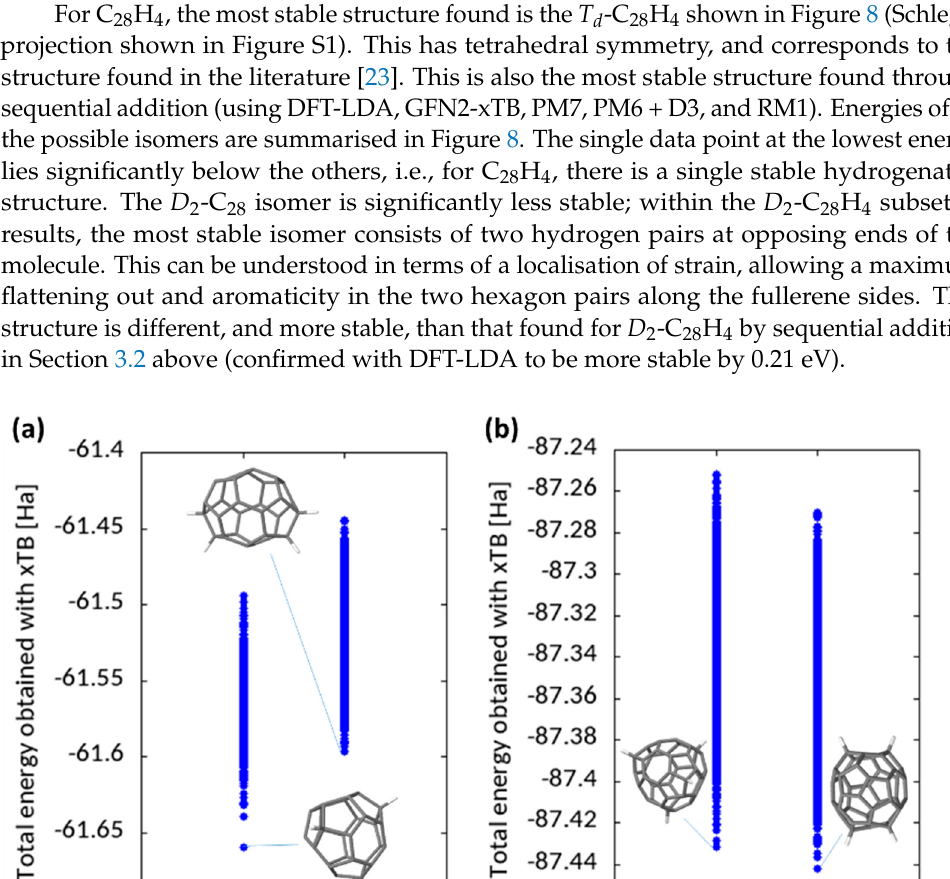
Table 2. Comparison of empirical and semi-empirical methods with DFT. Run time is the average of 10 runs for pure C 20 . r is Pearson’s correlation coefficient from